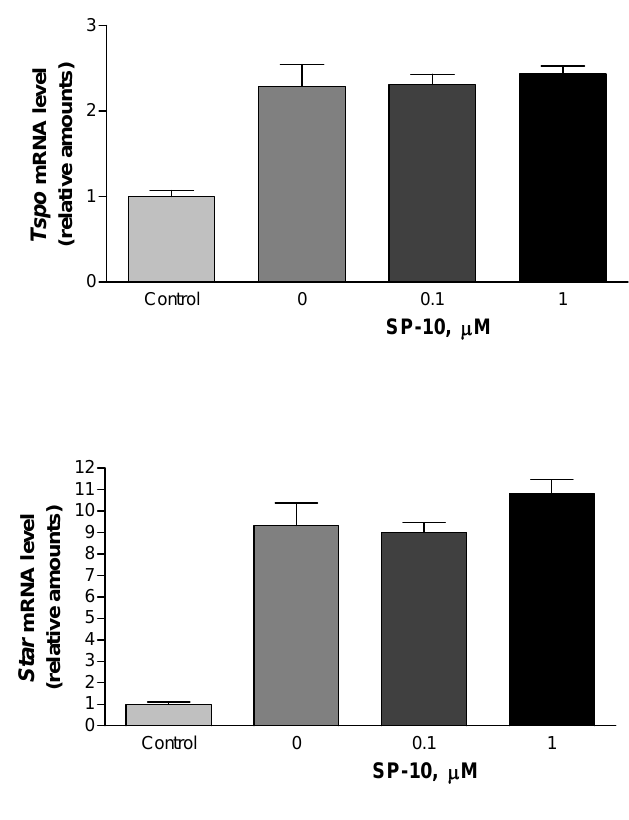
Figure 5. Effect of SP-10 on Tspo and Star mRNA levels. Y-1 cell were treated with the indicated concentrations of SP-10 for 24 h. This was followed by treatment with 1mM dbcAMP for 24 h. Tspo and Sta mRNA levels were quantified by Q-PCR. Results are significantly increased by dbcAMP (p < 0.05,